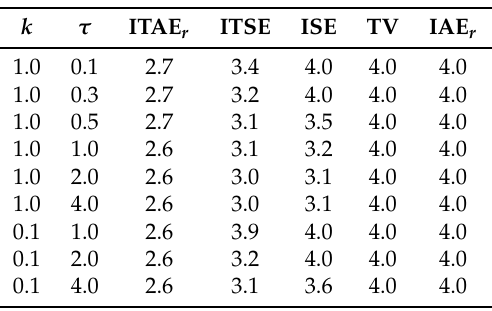
Table 5. Consider PI controller settings for an IPTD system, H p ( s ) = k e − τ s k , and time delay τ ≥ 0. The table illustrates ¯ c min = arg min ITAE r and ITSE indices as a function of ¯ c , with PI controller settings from Algorithm 1.